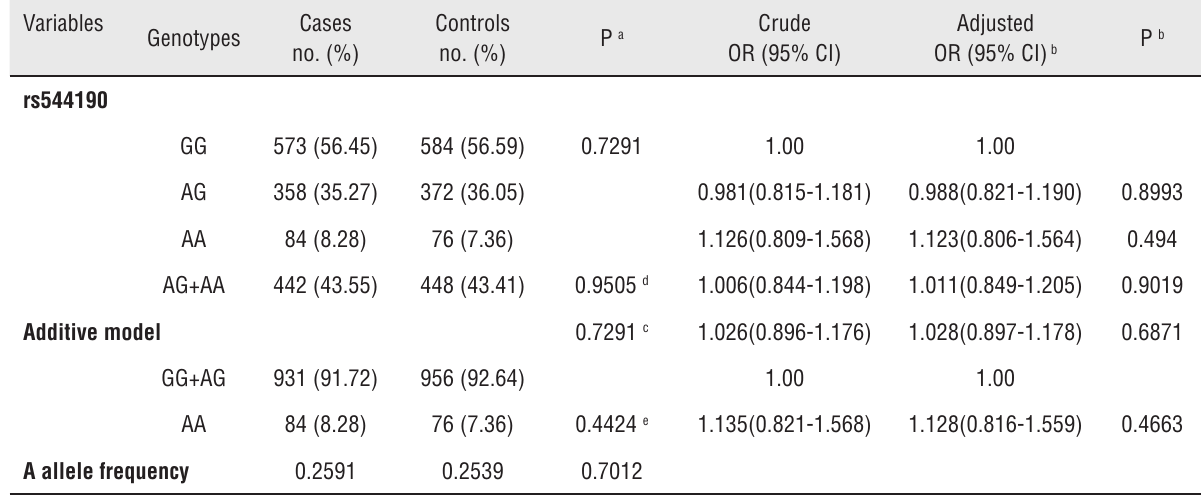
Table 1 - Logistic regression analysis of associations between pcA3 variant genotype and prostate cancer